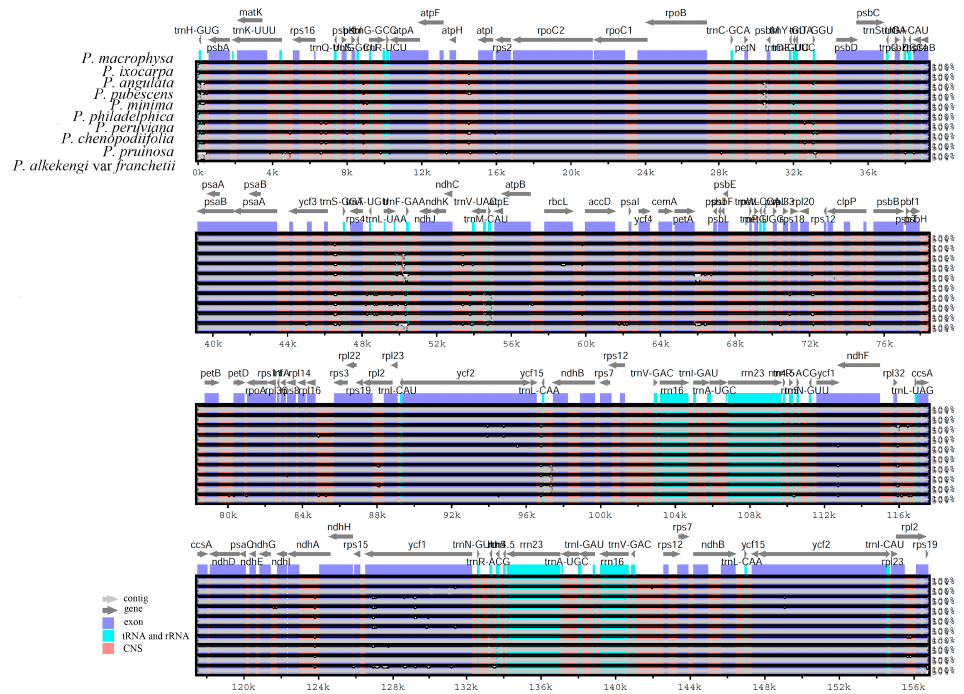
Figure 6. Complete cp genome sequence alignments of 10 Physalis species using the mVISTA program, with the cp genome of PMA as reference. The horizontal axis indicates the coordinates within the cp genomes. The vertical scale indicates the percentage identity within 50–100%.